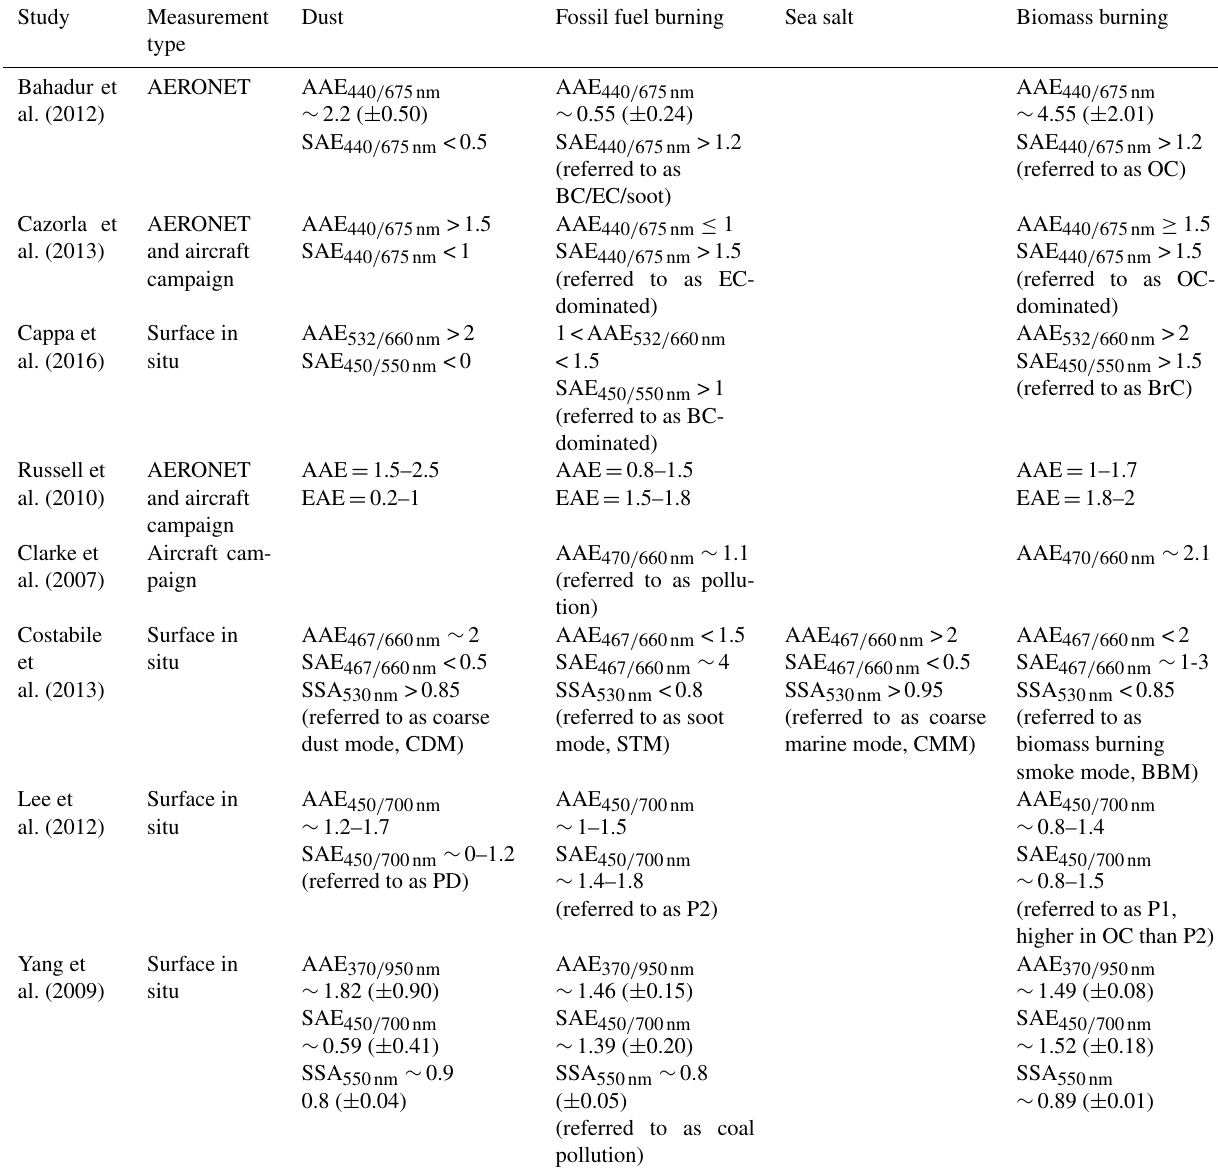
Table 1. Aerosol optical property thresholds used to determine aerosol type in previous studies. Values in parentheses represent standard deviations, when